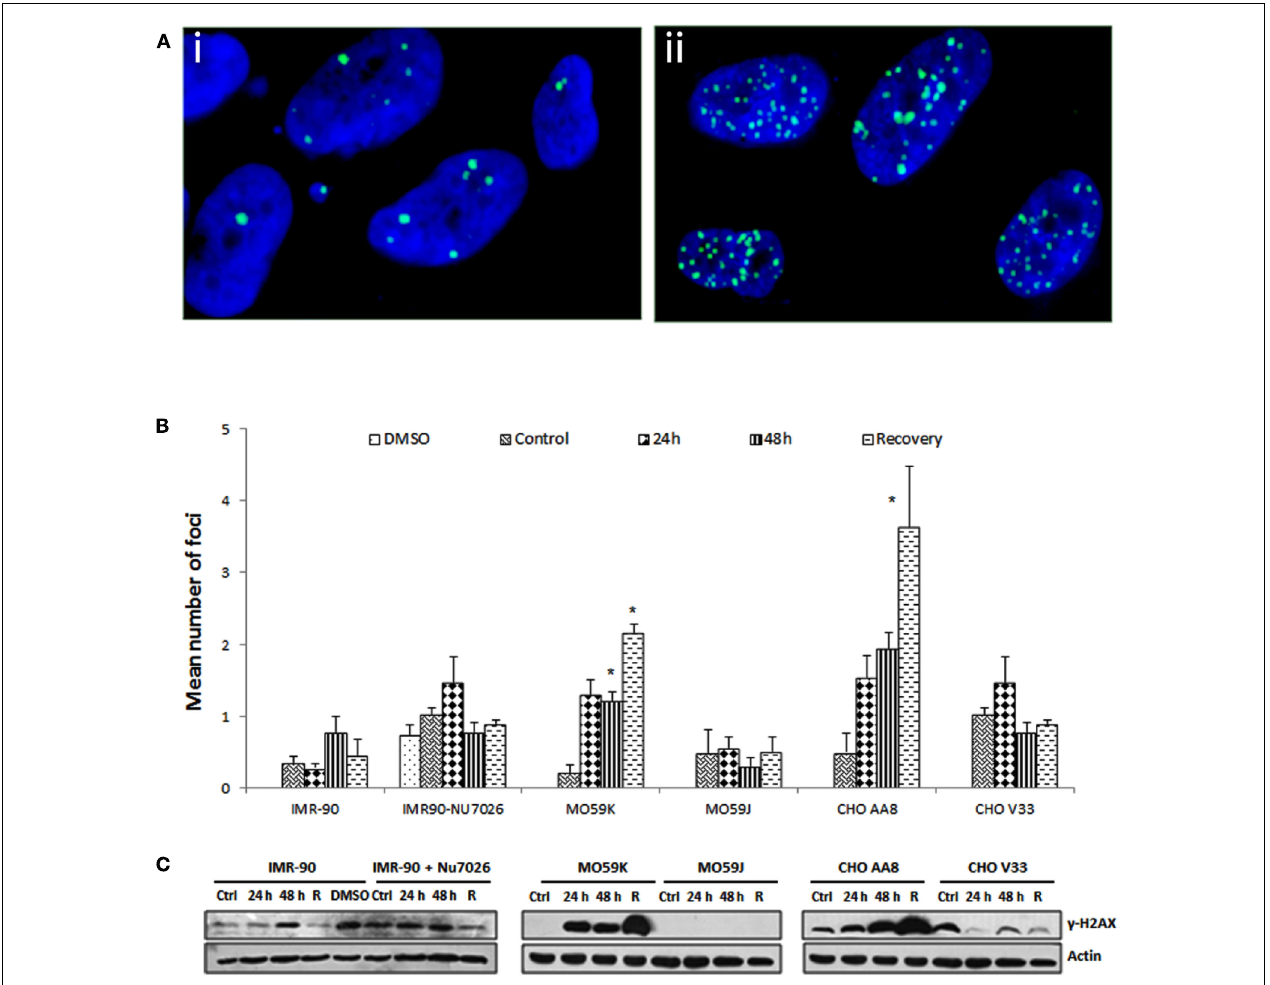
p < 0.05. (C) Western blots analysis of γ -H2AX following Ag-np treatment.Whole cells were trypsinized and lyzed. Equal amounts of proteins were loaded and separated using 12% SDS-PAGE, transferred to nitrocellulose membrane and immunoreacted with antibodies against proteins of interest. Actin was used as loading control. R denotes 48h